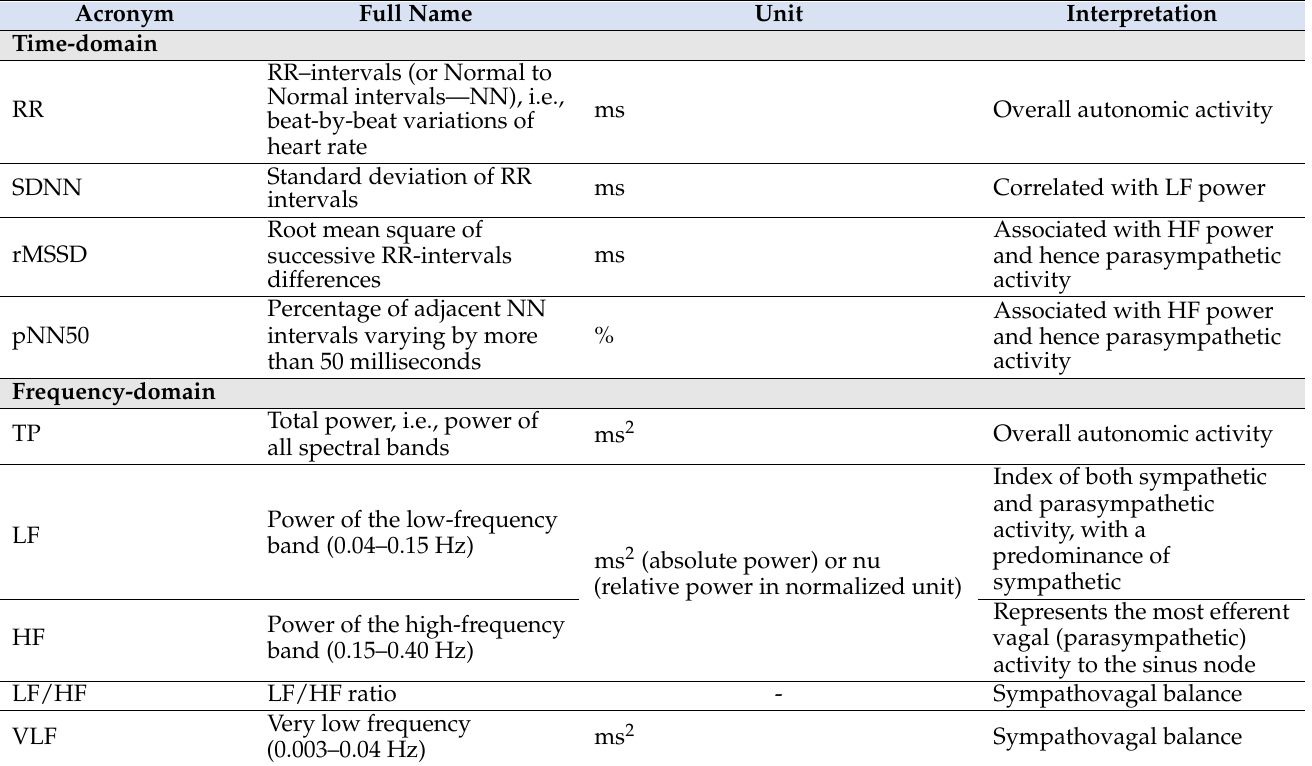
Table 2. HRV components